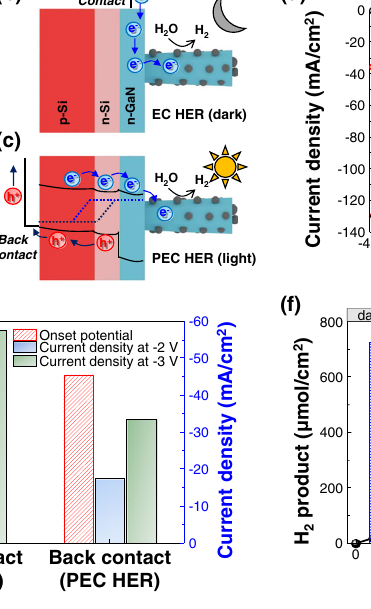
electrodemeasured with 2-electrodecon fi guration in 0.5M NaCl solution. e Onset potential and current density at − 2 and − 3V for front and back contacts. Onset potentialwasde fi nedasthepotentialat − 10mA/cm 2 . f AmountofH 2 producedand faradaic ef fi ciency measured at − 2 and 3V under dark (front contact) and light (back contact)